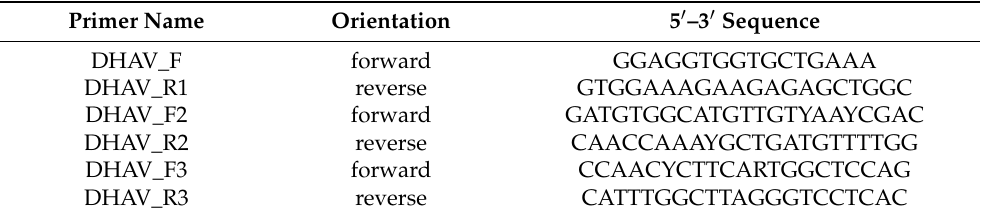
Table 1. Primer sequences used for the reverse transcription and amplification of duck hepatitis A virus genomes in this